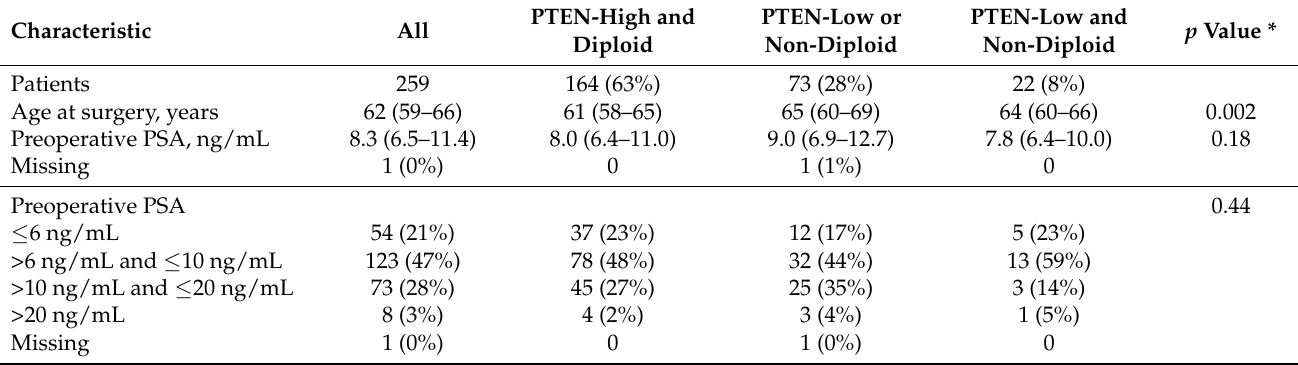
Table 1. Clinicopathological characteristics for all patients in the validation cohort stratified by the combined DNA ploidy and PTEN